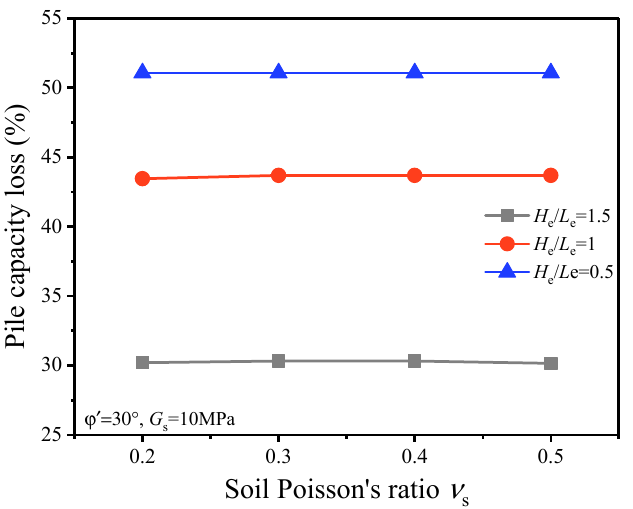
Figure 16. Effects of soil Poisson’s on pile uplift capacity loss with various ratios of excavation depth to effective pile length.